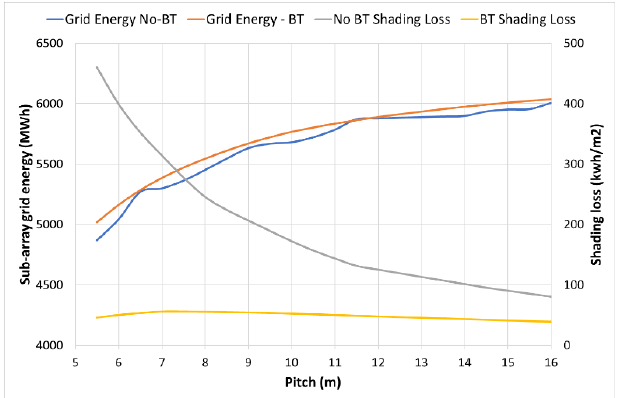
Figure 7. Sub-array grid injected energy and shading loss as a function of pitch; backtracking (BT) vs. no backtracking; landscape; central inverter.